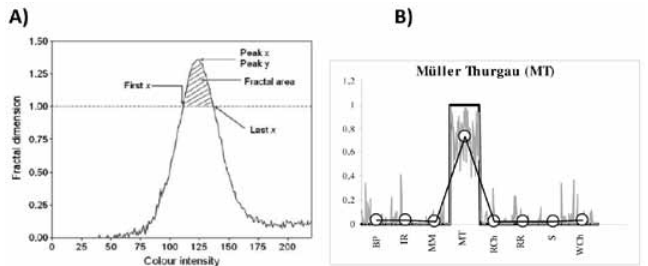
Fig. 1 - Fractal spectrum of one leaf and identification of five parameters to be implemented in the ANN. Graphical representation of Frac- tal parameters: Theoretical situation (A); and a real value (B).